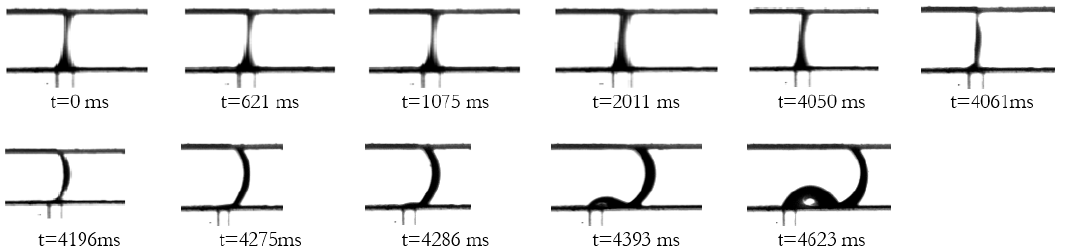
Figure 7. Water bridge/plug evolution.